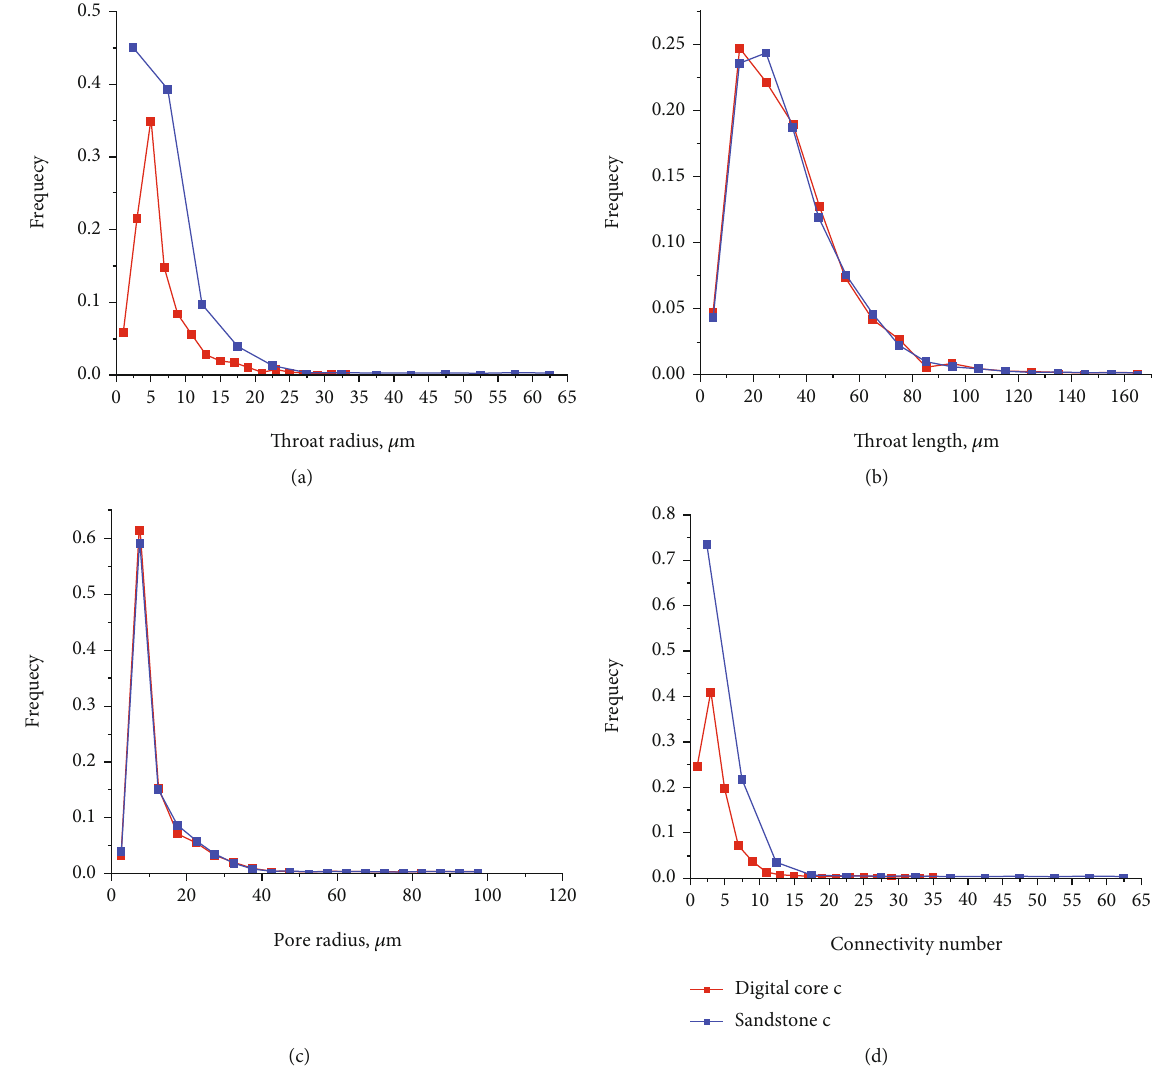
Figure 18: Pore-throat parameters of digital core c and sandstone c: (a) throat radius; (b) throat length; (c) pore radius; (d) connectivity